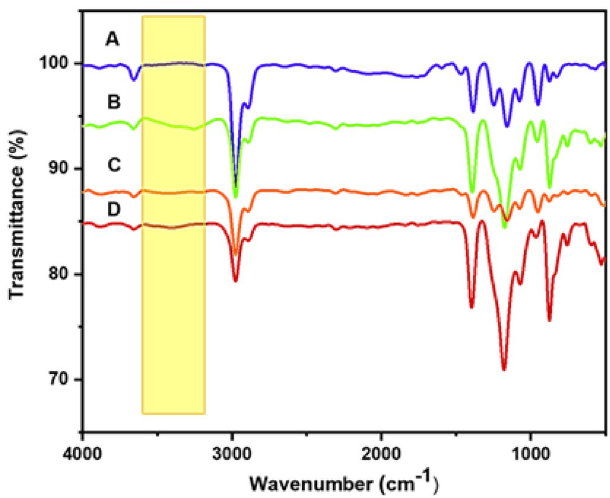
Figure 3. FTIR spectra of ( A ) M-0 , ( B ) M-1 , ( C ) M-2 , and ( D ) M-3